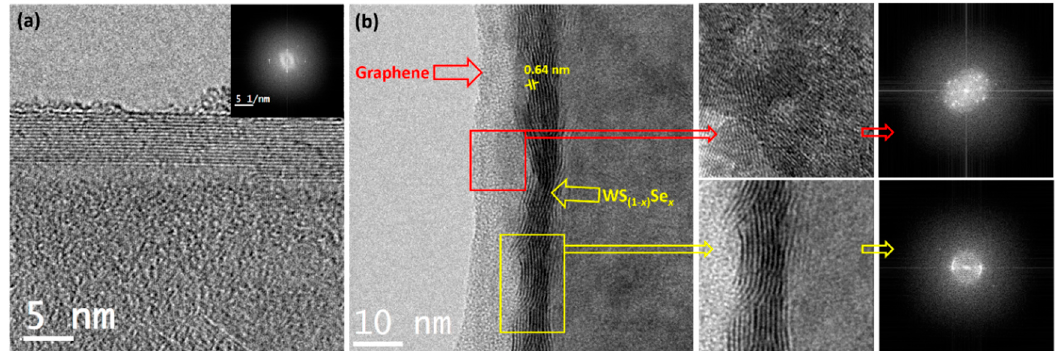
Figure 3. HRTEM images of ( a ) graphene/NF and ( b ) WS (1 − x ) Se x /graphene/NF. The layer spacing value is indicated as 0.64 nm, which is related to a (002) lattice plane d-spacing value. High-resolution HRTEM images show the corresponding graphene (red line) and WS (1 − x ) Se x (yellow line) lattice structures with selected area electron diffraction (SAED) pattern.